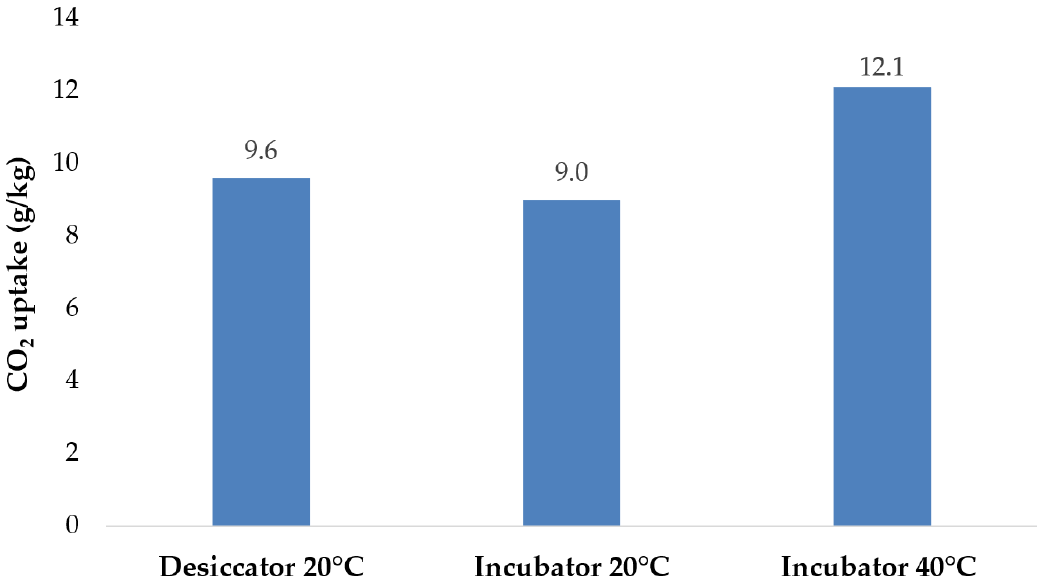
Figure 10. Effect of the temperature on CO 2 uptake (water content of 2.8%) (one accelerated carbonation test for these RCAs at this same water